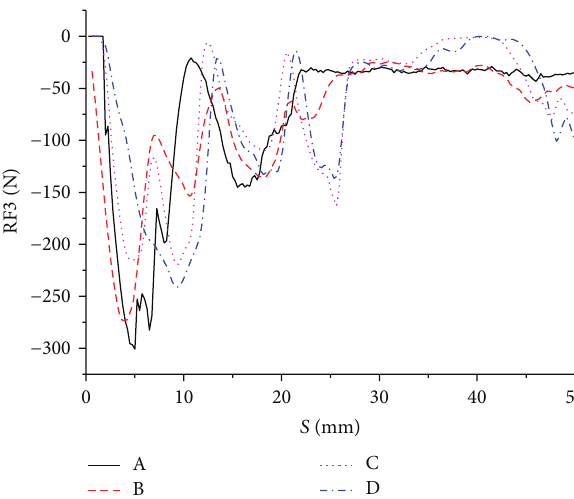
Figure 6: Reaction force of 4 blades along the 𝑧